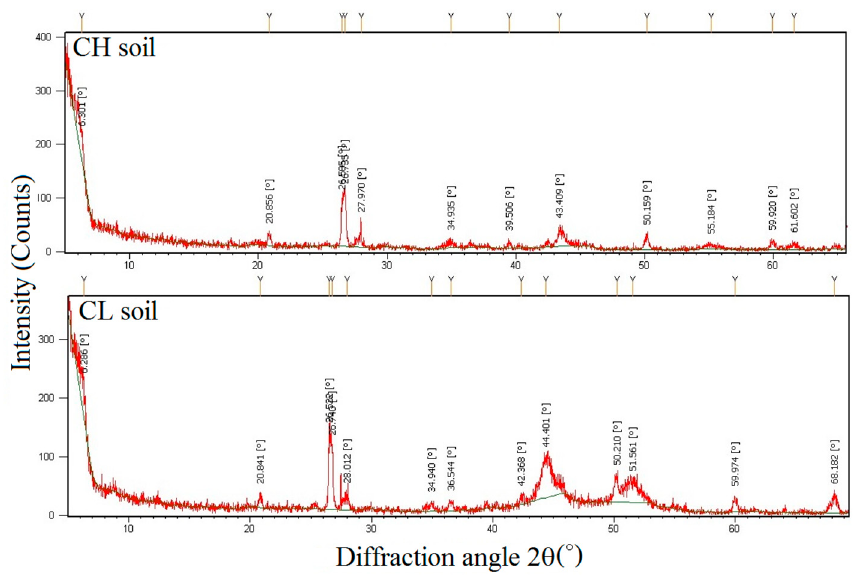
Figure 2. XRD analysis of soil samples. Table 1. Physical and chemical properties of soil samples.